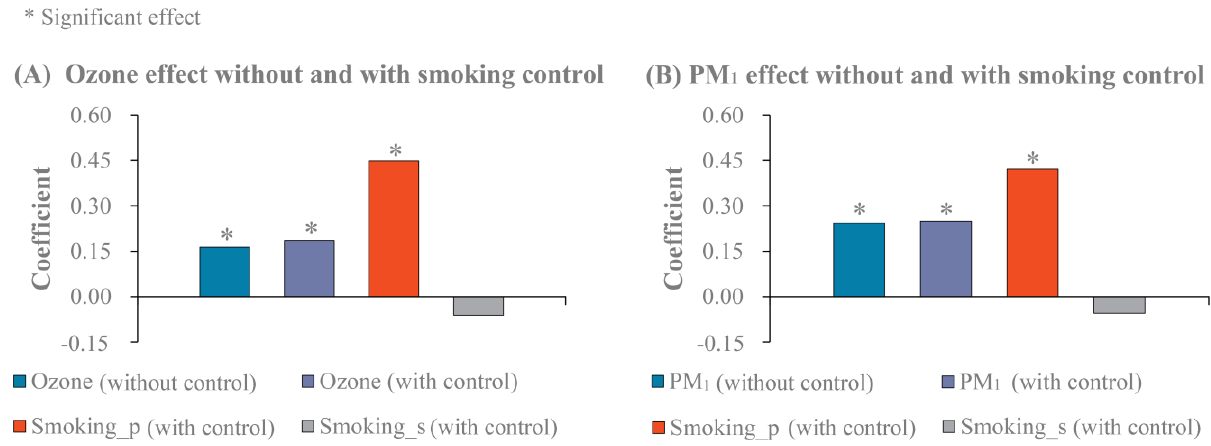
Figure 3. Sensitivity analyses of ozone and PM 1 effects to the adjustment of smoking covariates. Smoking_p and smoking_s